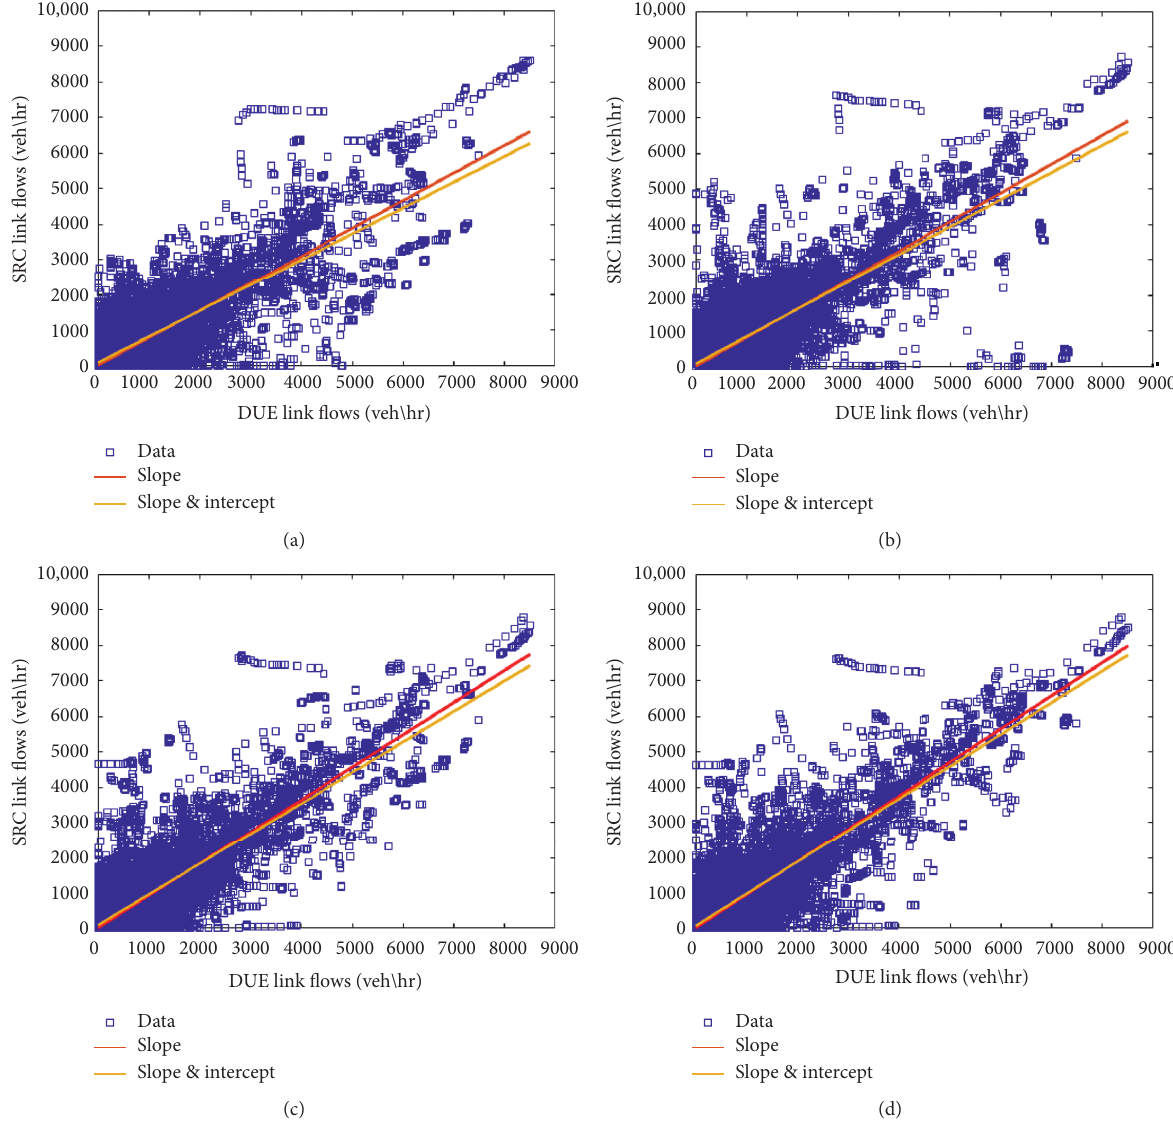
Figure 7: Scatterplot of individual link flows: comparing the SRC (with random seed 28,678) with different levels of driving adaptiveness (a) 0%, (b) 20%, (c) 60%, and (d) 80% in comparison to the DUE link flows. X -axis displays link flows estimated by DUE in veh/hr and y -axis represents the link flows estimated by the SRC model in